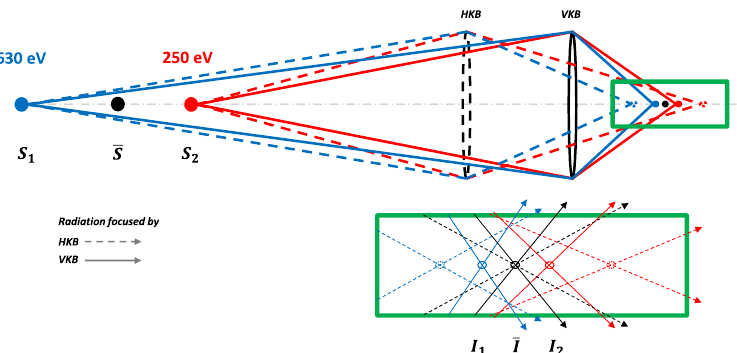
Figure 9. Schematic representation of the focusing conditions for two-color lasing at SASE3. If both KB mirrors are tuned in order to minimize the astigmatism for imaging the virtual source ¯ S , located between sources S 1 and S 2, then the images at planes I 1 and I 2, separated by 1.3 mm, suffer from aberration. However this solution allows one to obtain good radiation quality and comparable photon densities at the ¯ I image plane (see lower figure and Figure 10).